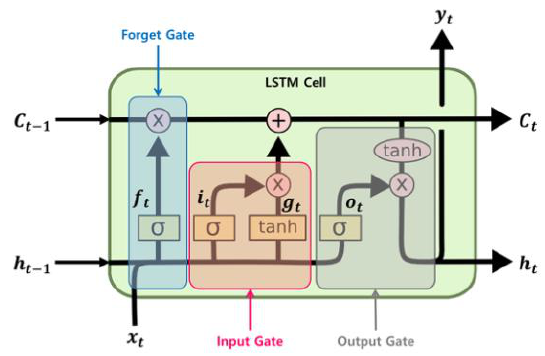
Figure 4. Long short-term memory (LSTM) cell structure [27].